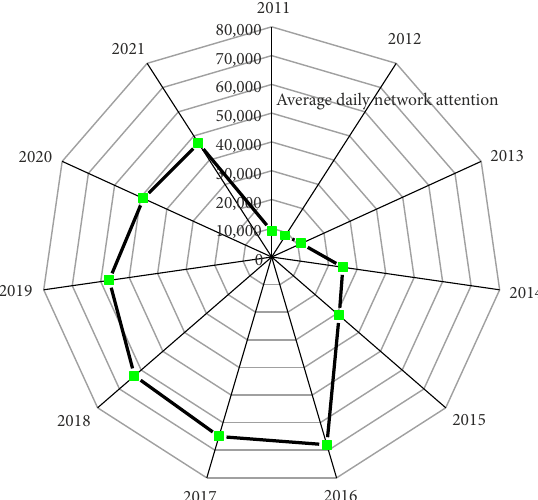
Figure 5. Average daily OPA from 2011 to 2021